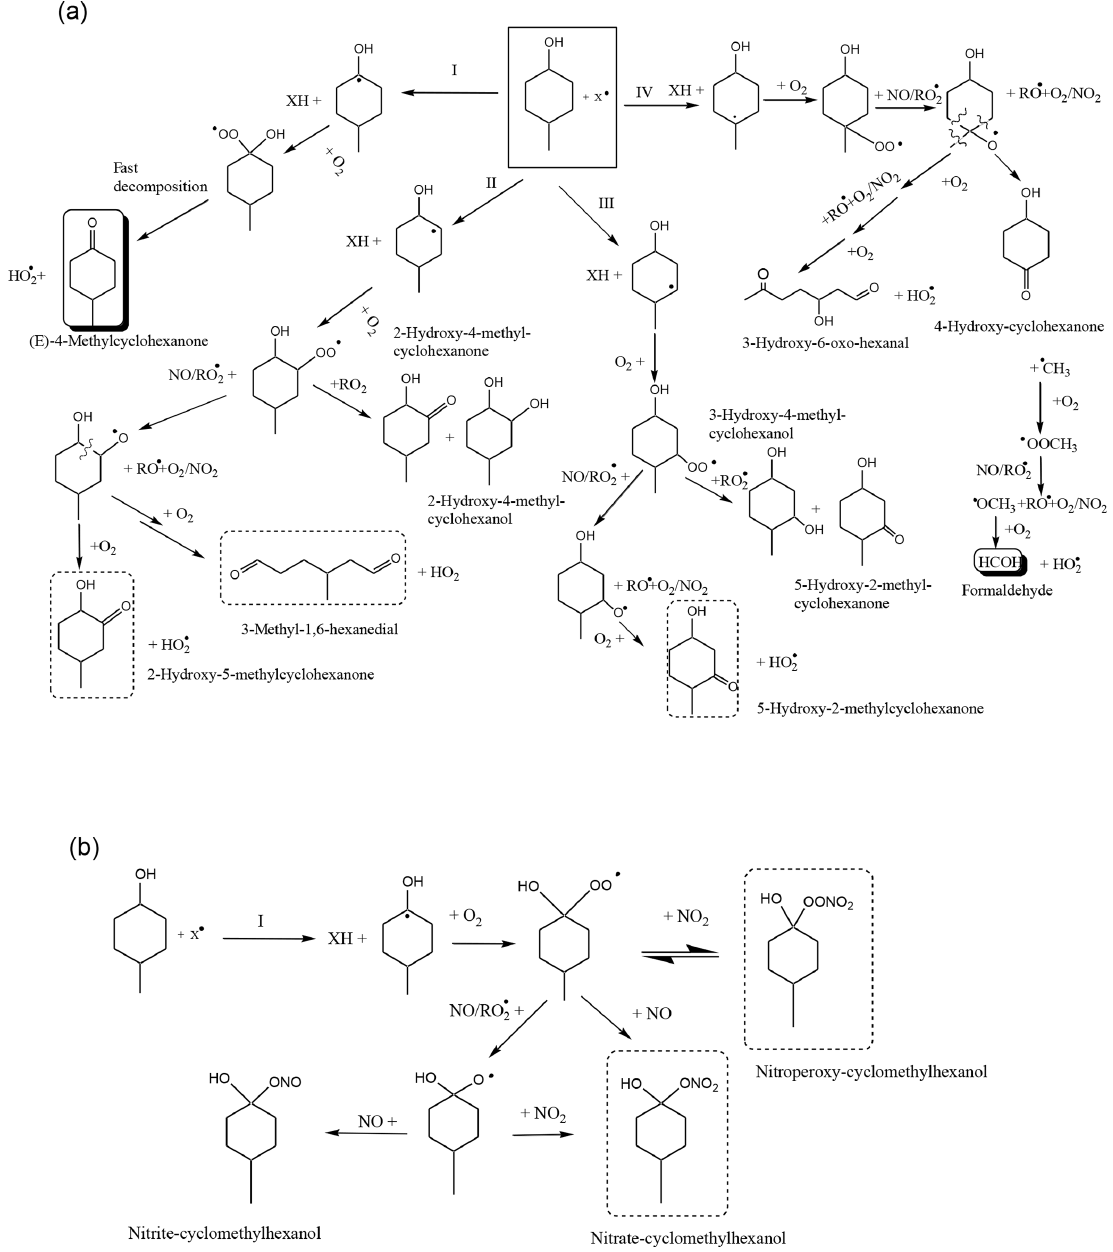
Figure 5. Reaction mechanism for the degradation of 4MCHexOH with X (the Cl atom and the OH and NO 3 radicals). (a) The mechanism for the formation of carbonyl compounds. (b) The mechanism for the formation of nitrated compounds. Compounds marked with a solid line are positively identified. Compounds marked with a dotted line are not positively